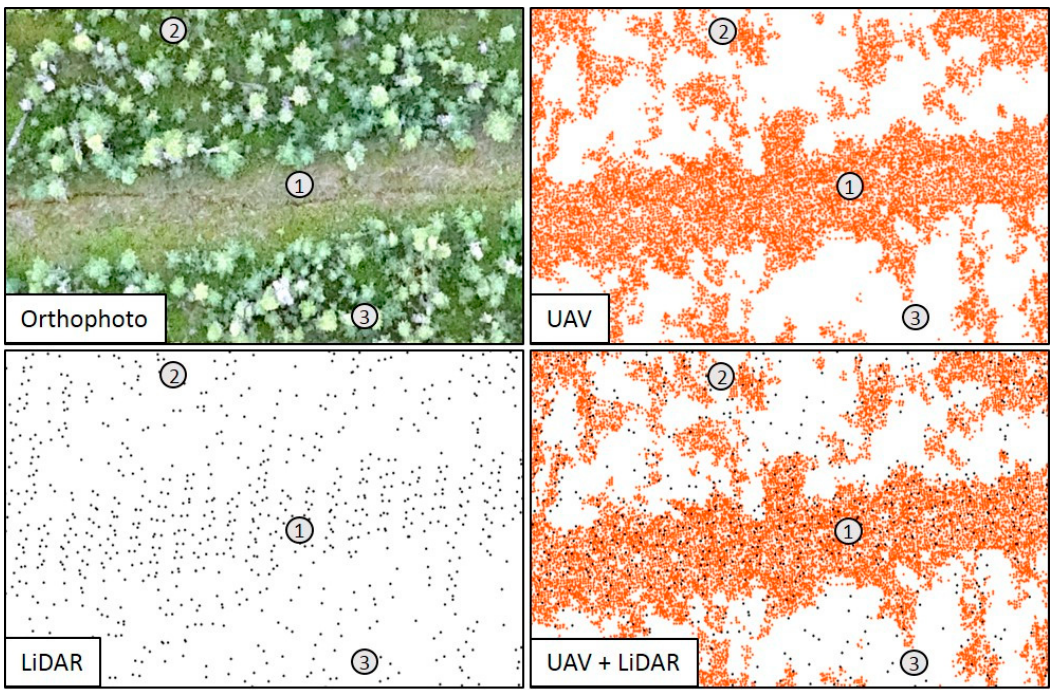
Figure 5. Comparison of vegetation influence on dataset point densities, modeling a seismic line and adjacent undisturbed peatland. Examples of each surface complexity class indicated as: ① = Class 1 (low); ② = Class 2 (moderate); ③ = Class 3 (high).